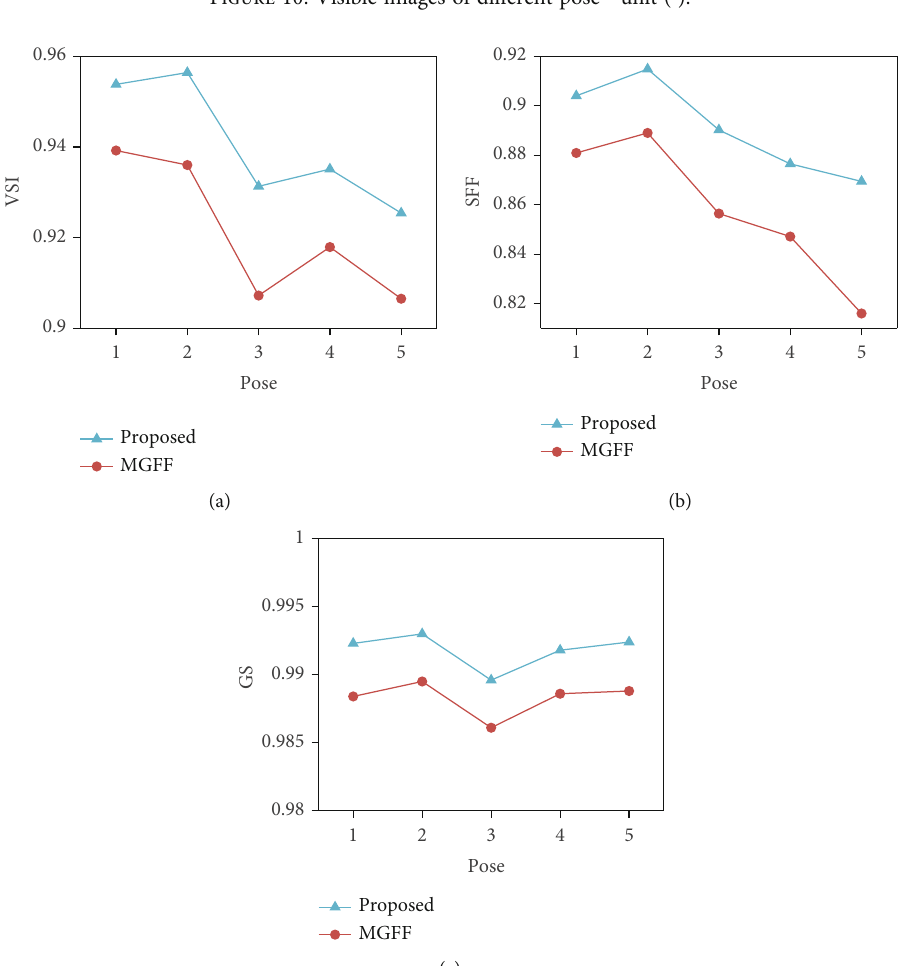
Figure 11: Fusion performance in di ff erent pose of space